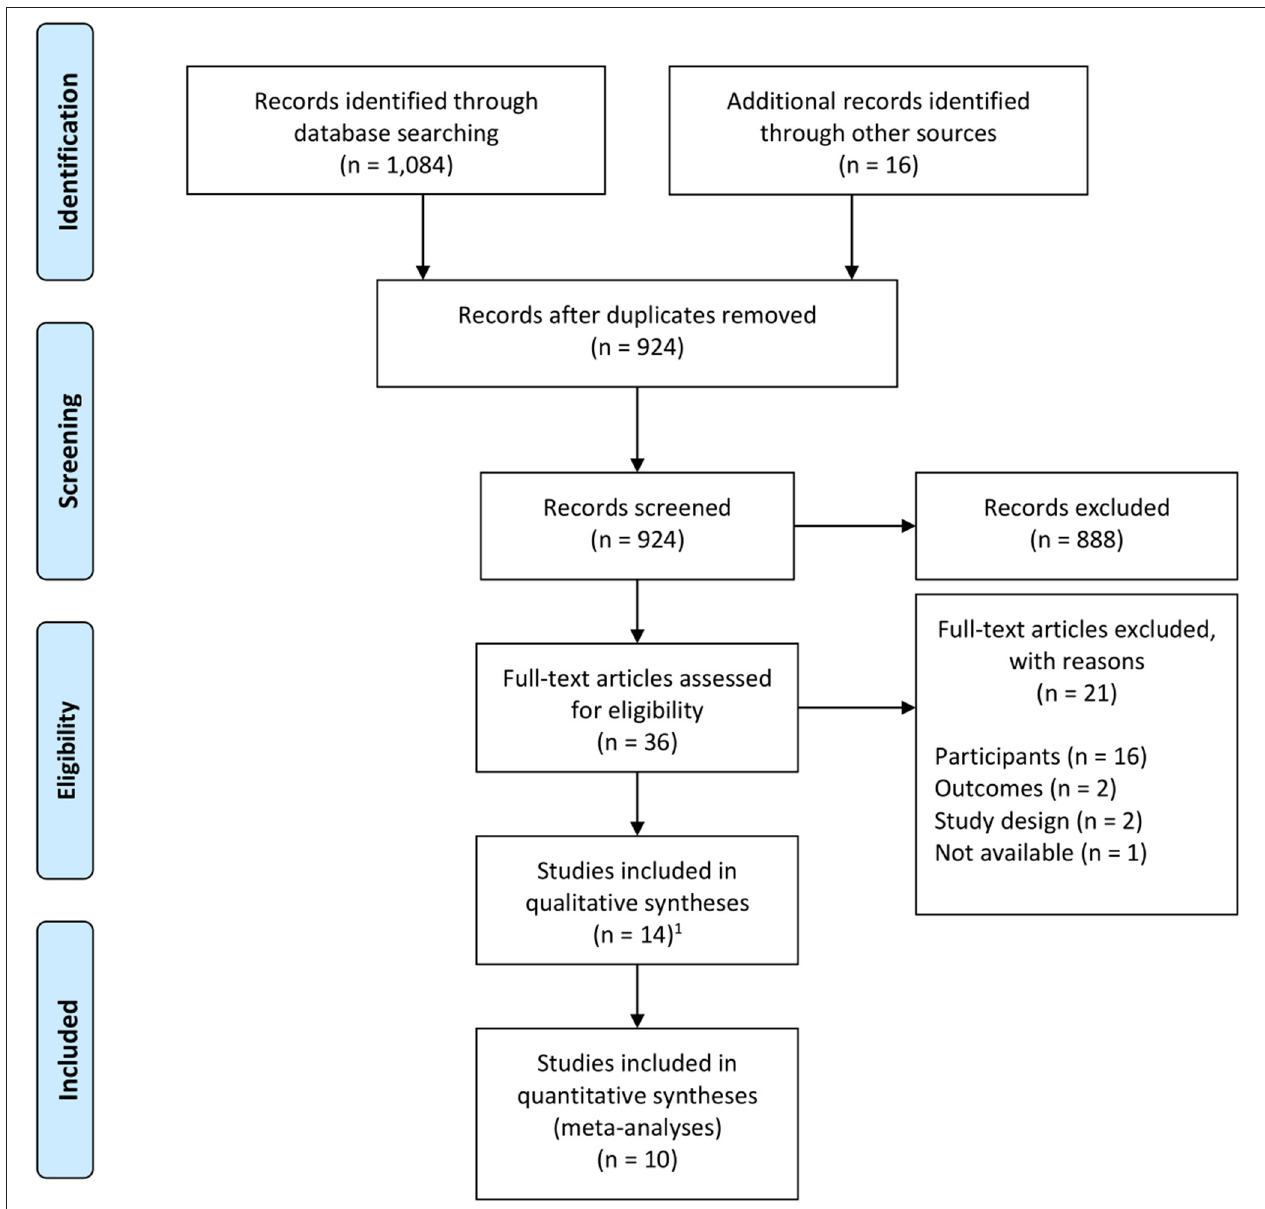
FIGURE 1 | Flow diagram. 1 The 14 included studies were reported in 15